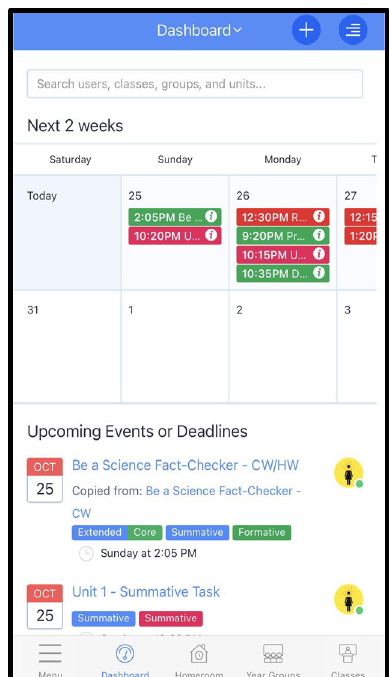
Figure 3c . Teachers view of assigned classes